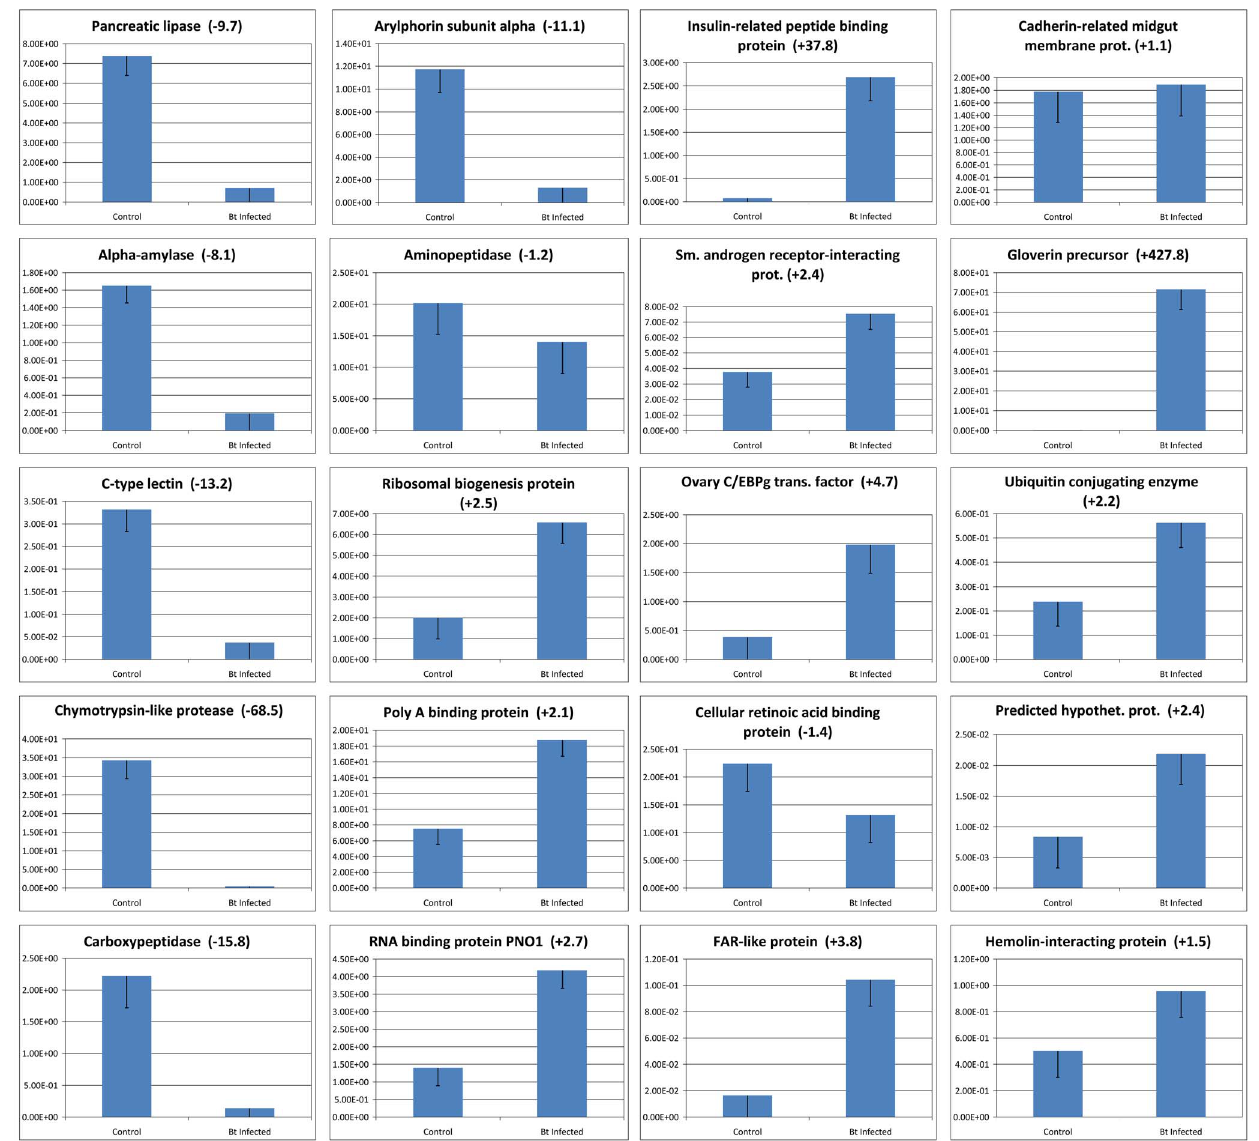
Figure 3. qRT-PCR Results. Quantitative real-time PCR analysis data for 20 select Lymantria dispar midgut genes are presented. Three technical replicates were performed for each of three biological replicates. The height of each box represents the mean average of sample-specific 2 - D Ct values, while associated error bars denote the standard error of the mean. Fold changes are shown in parentheses.